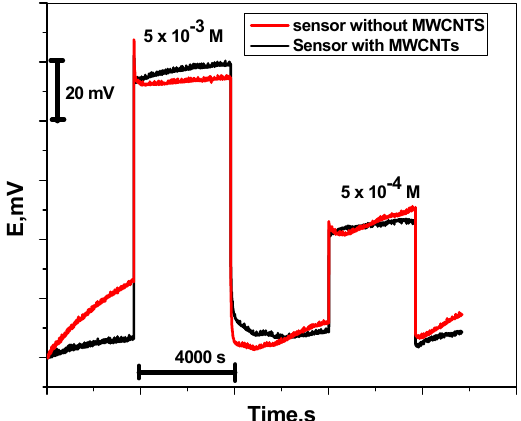
Figure 5. Water layer test for Tl membrane based sensor in the absence and presence of MWCNTs.